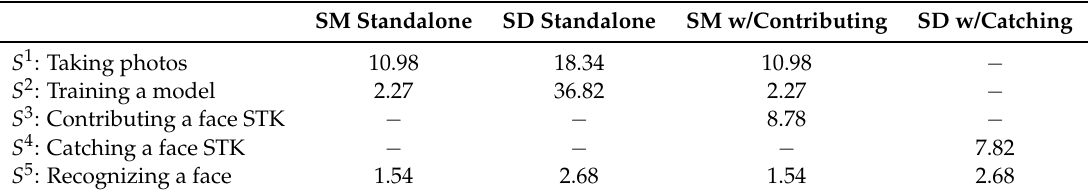
Table 1. Measurement of the time spent on each step (seconds).